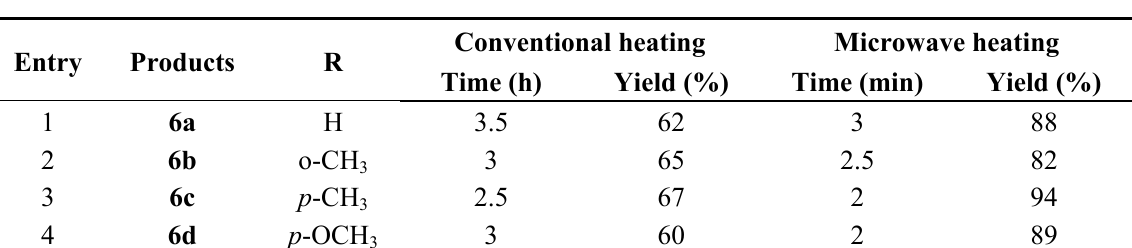
Table 1. Influence of microwave irradiation and conventional heating on the synthesis of benzimidazole derivatives 6a – d .